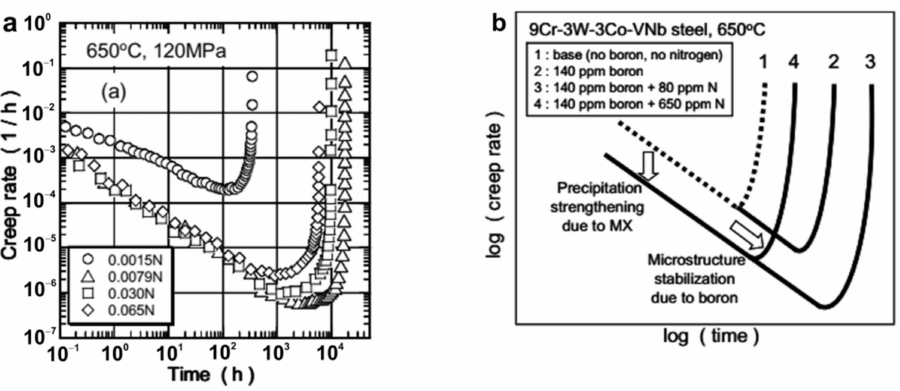
Figure 12. Effect of nitrogen on creep rate versus time curves of the steels at 650 ◦ C and 120 MPa ( a ) and ( b ) mechanisms of boron and nitrogen effect on creep rate versus time curves. Reprinted with permission from Ref. [13]. Copyright 2011